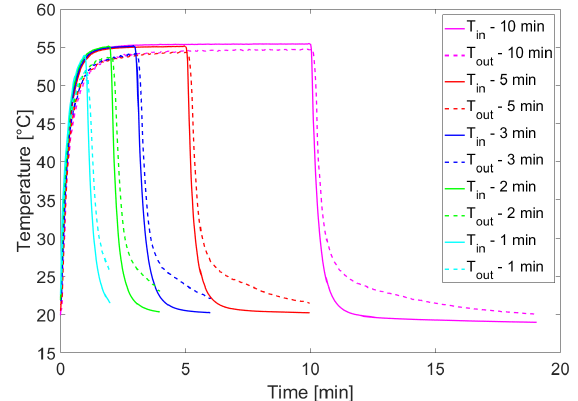
Fig. 4. Inlet and outlet water temperature for di ff erent charg-ing / discharging time intervals .